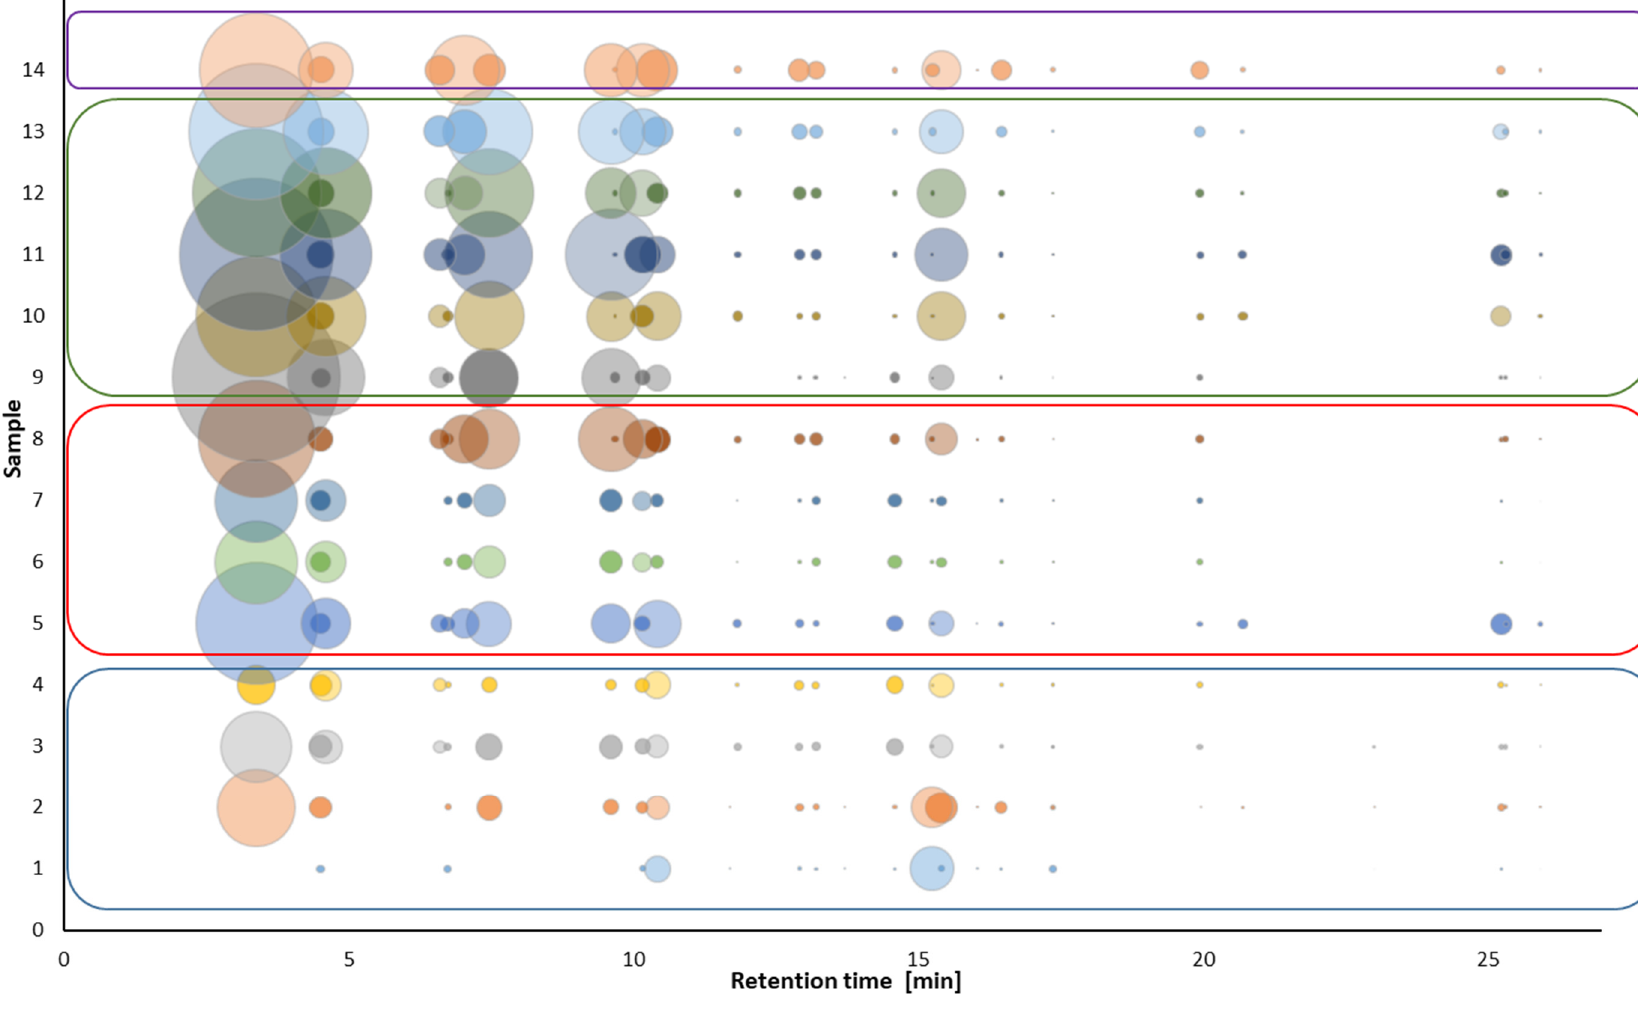
Figure 6. Comparison of the phenolic profile of samples 1–14 obtained by HPLC analysis. Blue box—Greek balsamic vinegar; red box—BVM; green box—“premium“ BVM; Purple box—TBVM.